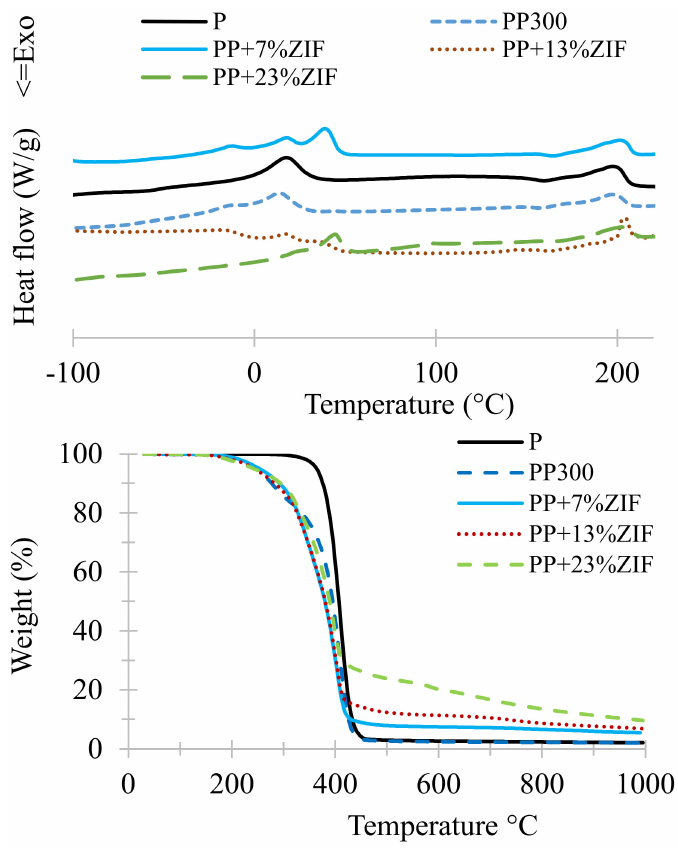
Figure 8. TGA and DSC curves of Pebax/PEG/ZIF-8 membranes. Table 3. Thermal properties of neat Pebax, Pebax/ZIF and Pebax/PEG/ZIF